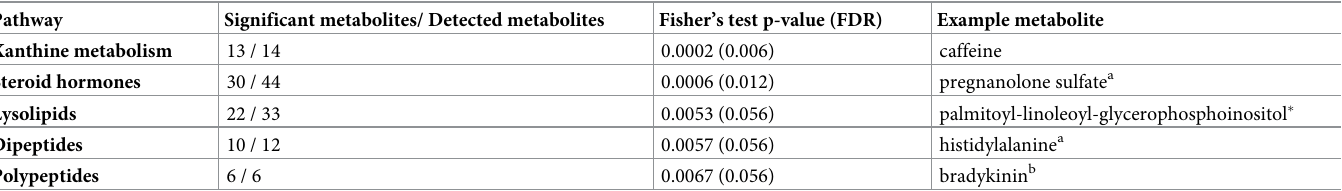
( e . g . leucylglycine (LG) is correlated with isoleucylglycine (IG), valylglycine (VG), glutamine- leucine (NL), leucylglutamine (LN), and glycylleucine (GL)). The bradykinin network con-